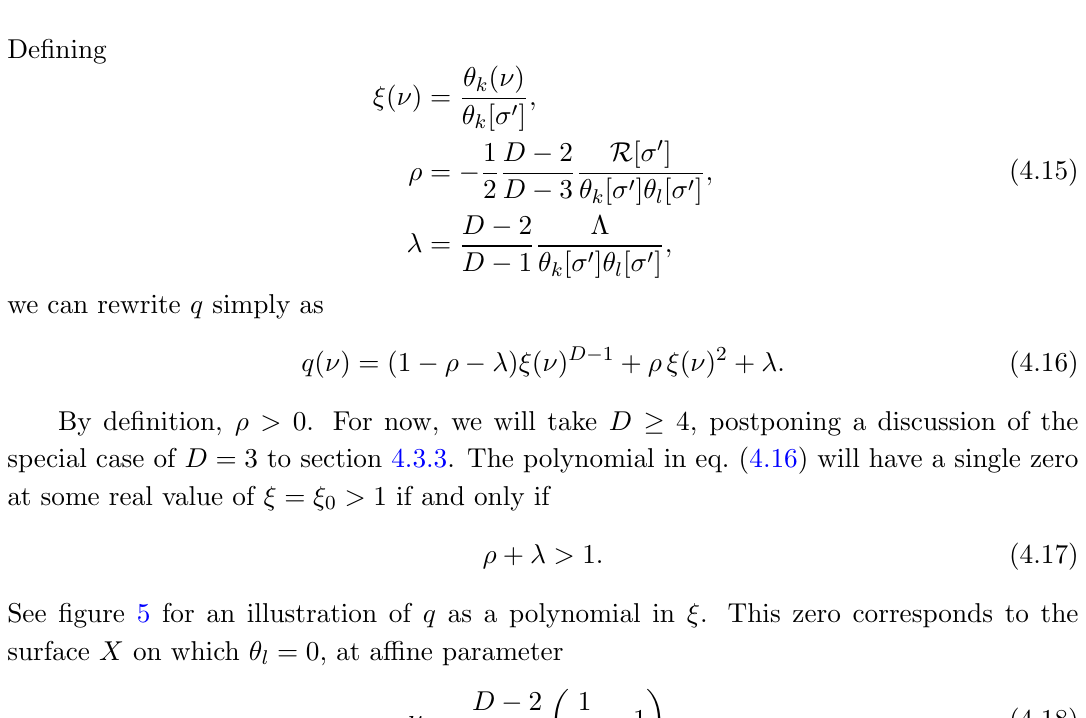
Figure 5 . Example of the polynomial q ( (cid:24) ) = (1 and (cid:26) > 0, but (cid:21) is allowed to take either sign. For D if and only if (cid:26) + (cid:21) > 1. For small (cid:24) , the polynomial behaves like (cid:26)(cid:24) 2 + (cid:21) , while for large (cid:24) , the dominant contribution is (1